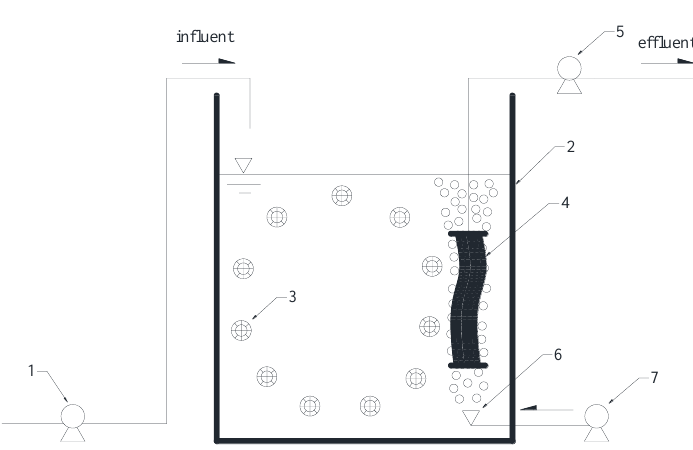
Figure 1. Schematic diagram of the hybrid membrane bioreactor (HMBR) setup. 1. feed pump; 2. aeration tank; 3. biofilm carrier; 4. microfiltration membrane module; 5. suction pump; 6. air diffuser;